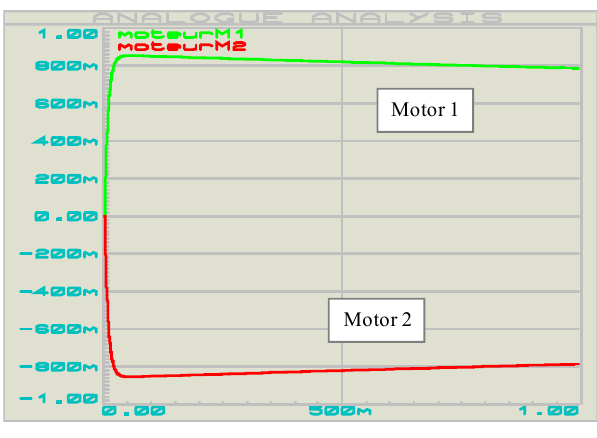
Figure 12. Variation of the current of motor 1and motor